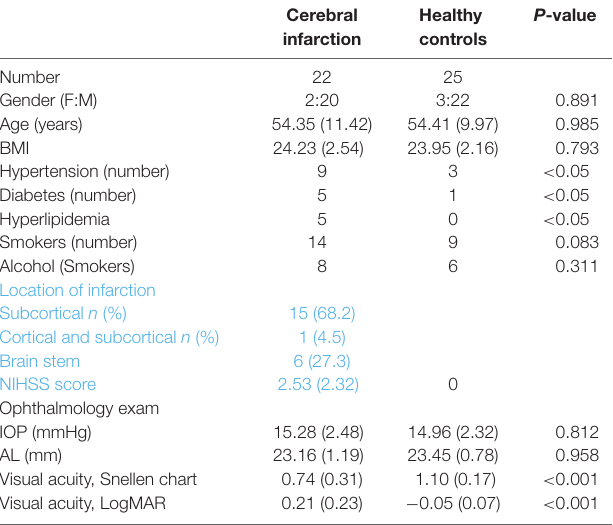
TABLE 1 | Demographics and clinical data.